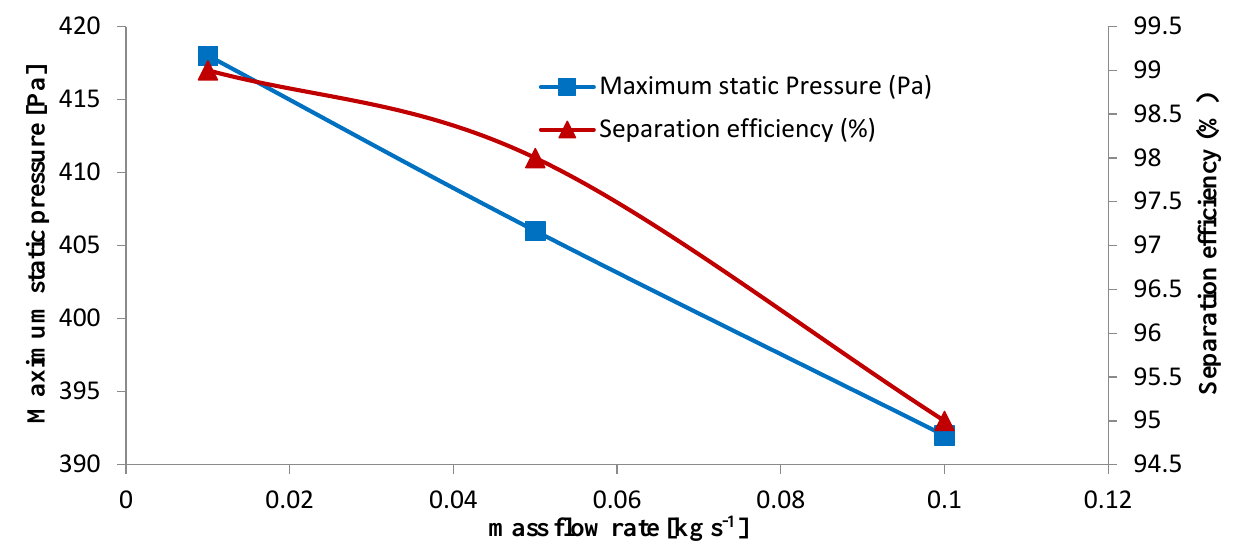
Figure 19. Maximum static pressure and separation efficiency variations in various mass flow rates.